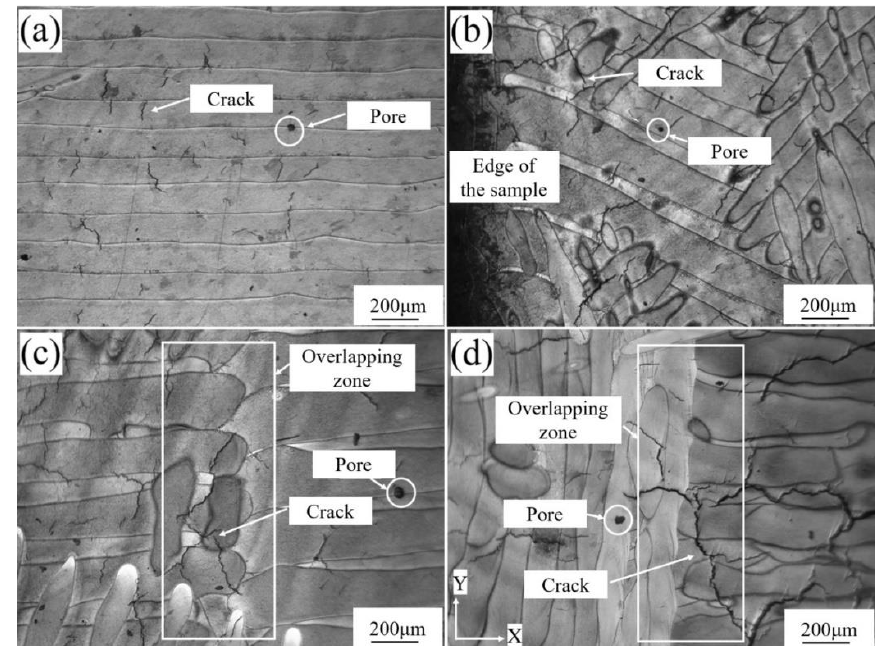
Figure 4. Metallographic microstructure of SLMed René 104 superalloy in the X–Y plane of the samples; ( a ) snake scanning; ( b ) merged molten pool at the edge of the snake scanning; ( c ) overlapping zone of the stripe-partition-scanned molten pool; and ( d ) overlapping zone of the chessboard-partition-scanned molten pool.